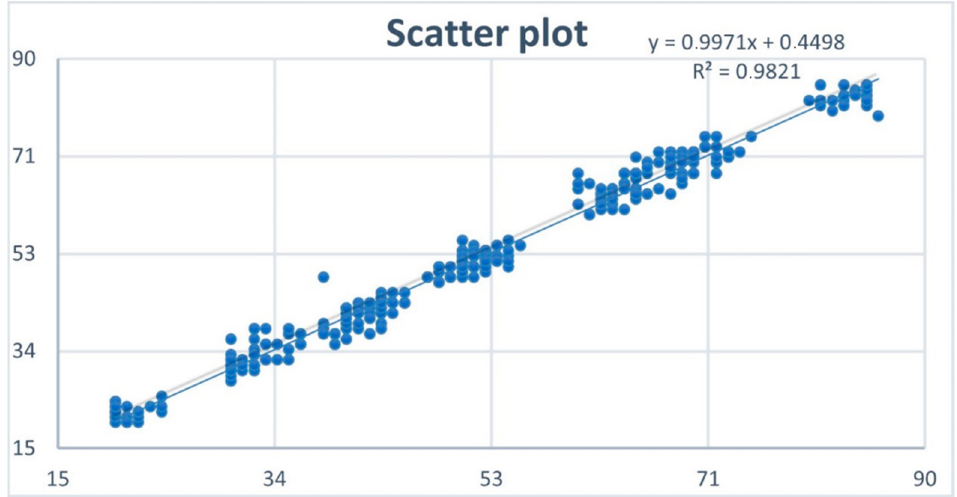
Figure 10. Scatter Plot about the agreement of ISQ measurement for each sample showing the vari- ability of the repeated